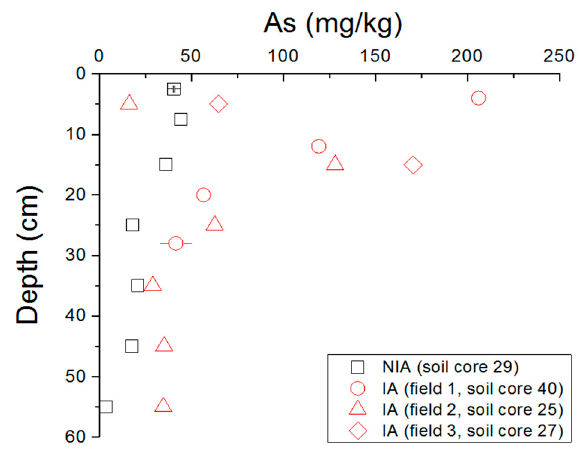
Figure 5. tAs in soil core samples from IA (samples 25, 27 and 40) and from NIA (sample 29).